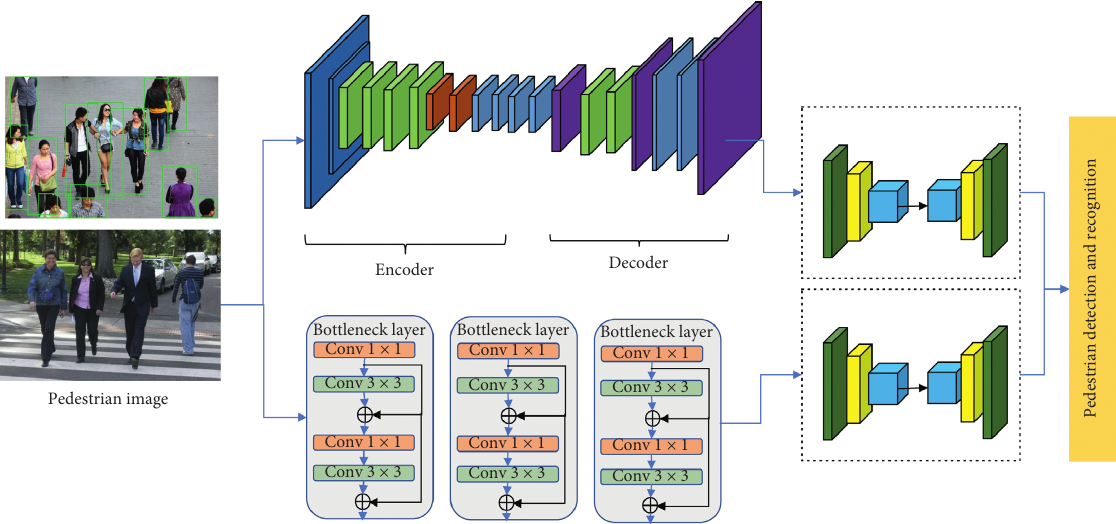
Figure 2: End-to-end pedestrian detection